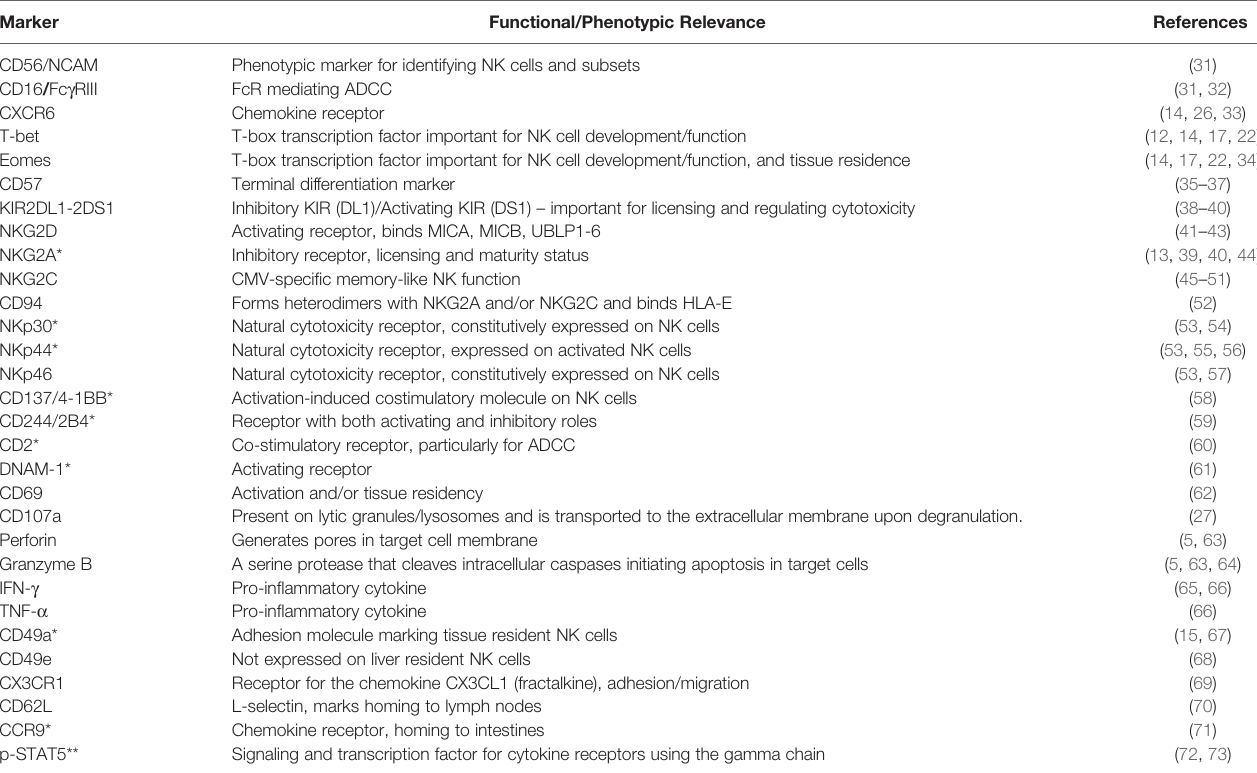
TABLE 1 | Analyzed cell surface and intracellular/nuclear markers, their scienti fi c relevance, and references.